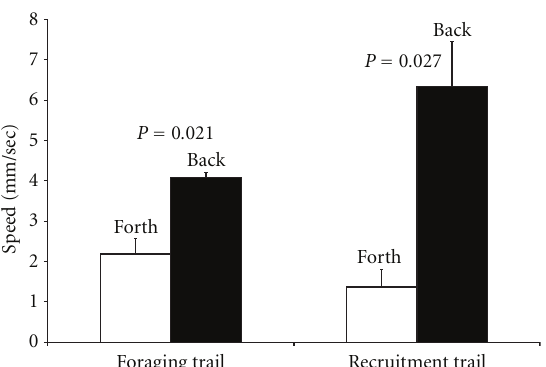
Figure 2: Mean travel speed ( ± SD) of the first worker following foraging or recruitment trails. N = 20; P values above bars correspond to the Wilcoxon matched-pairs test ( P < 0 . 05) for di ff erences between forth and back